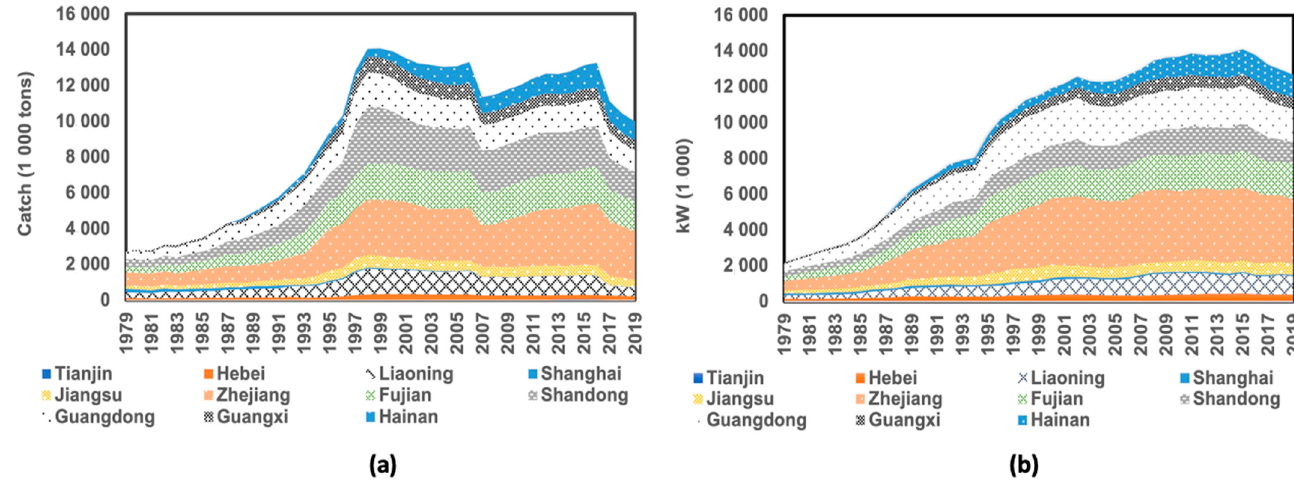
Figure 2. Regional representations. ( a ) Production status per region; ( b ) Trends in fishing capacity per region [20,21].